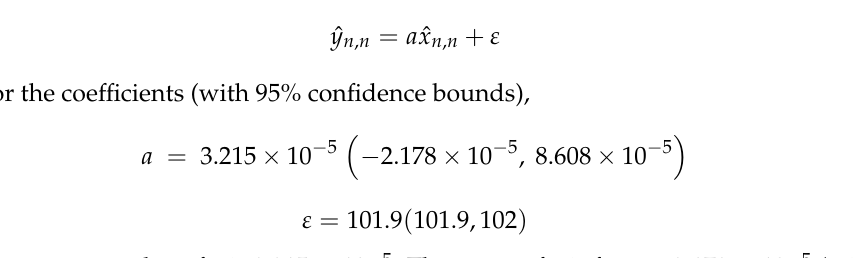
Figure 6. Comparison of the KF estimated distance and CFKF estimated distance (UWB anchor 1). For error modelling (CFKF),